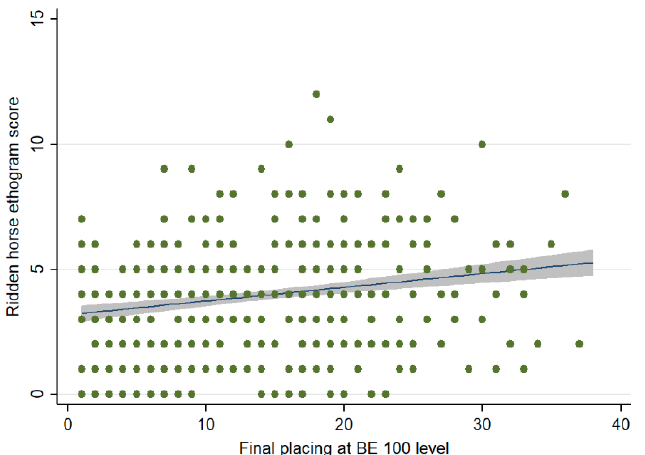
Figure 5. Comparison between the Ridden Horse Pain Ethogram (RHpE) scores and final placings at British Eventing 100 level. The green dots represent individual data points, the blue line is the best linear predicted fit and the grey area represents the corresponding 95% confidence interval. There was a weak positive correlation (rho = 0.263, p < 0.001) between the RHpE scores and final placings for 375 completions.